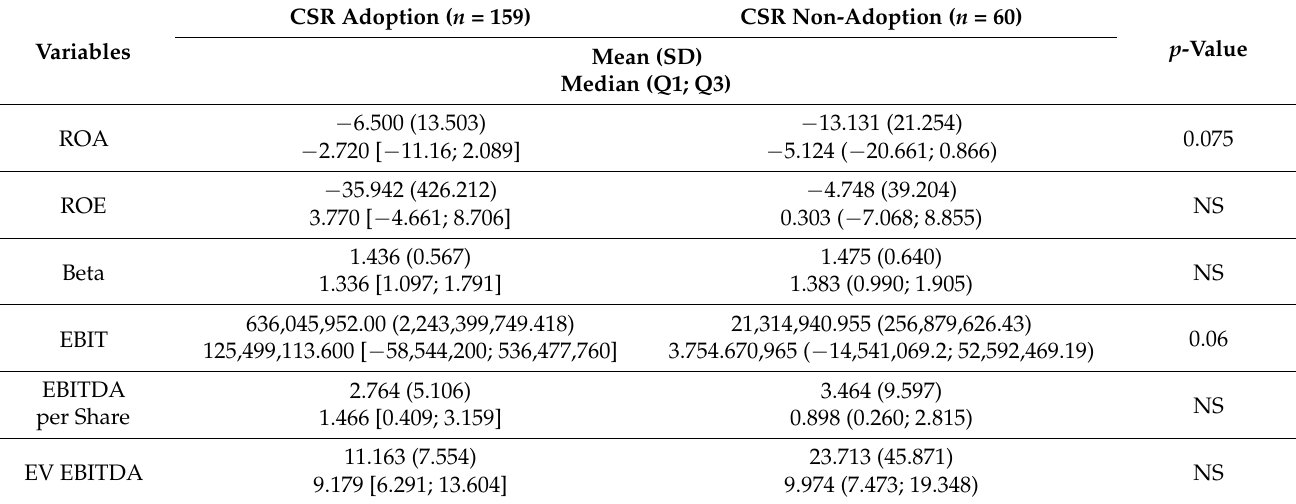
Table 3. Comparison of variables of companies that confirmed and did not confirm CSR